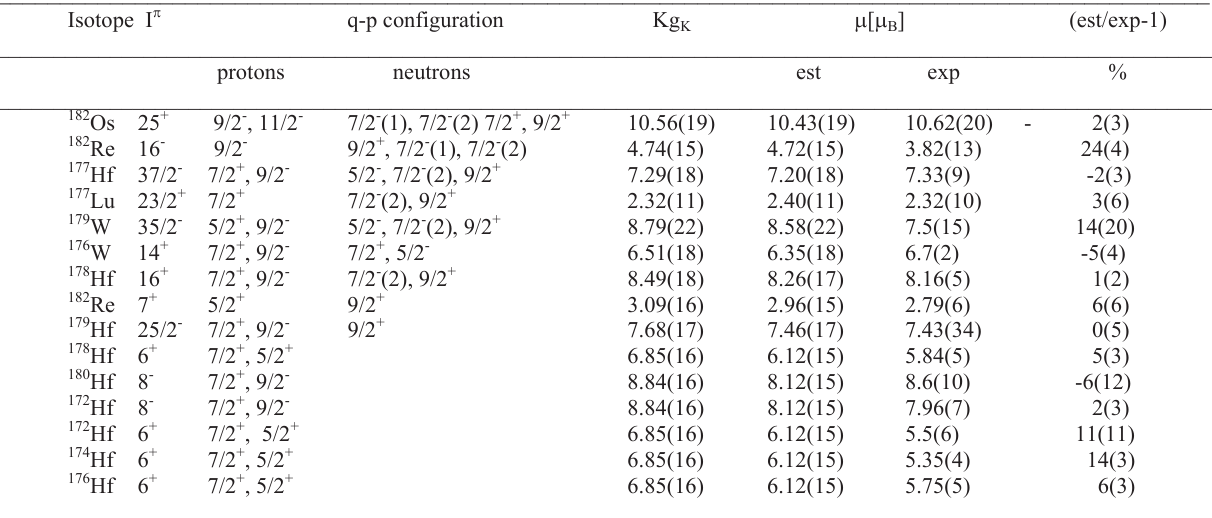
Table 2 Check for additivity in magnetic moments of multi-quasi-particle states. Kg K are from Eq. 6 and (cid:80) est from Eq. 2 with g R = 0.29(5). (cid:80) exp are taken from [10]. Nilsson labeling: proton states: 5/2 + [402}, 7/2 + [404], 9/2 - [514], 11/2 - [514]; neutron states 5/2 -